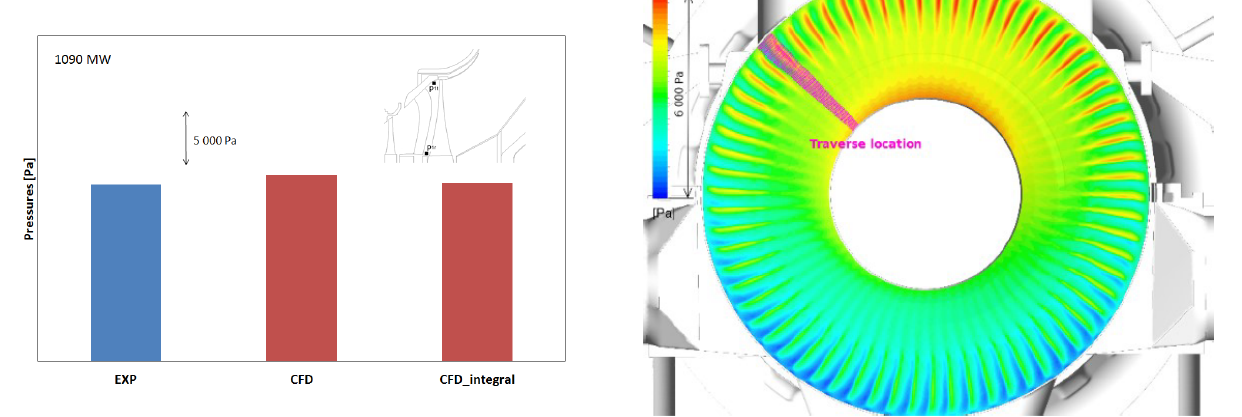
Figure 8. Static pressures behind stator row.